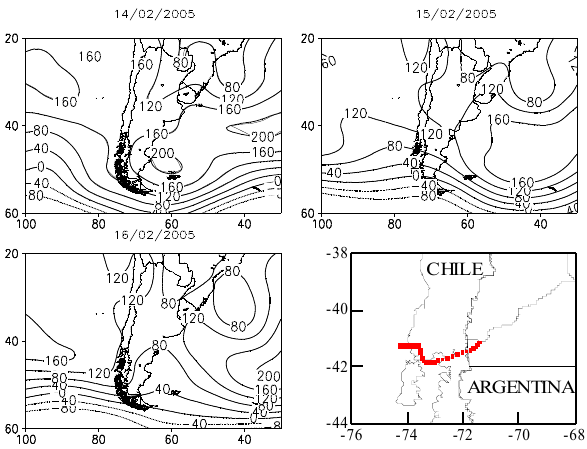
Fig. 4. Daily mean geopotential height fields of 1000hPa pressure surface for the day of Weinmannia pollen capture and 48 hours before. Bottom right panel: 48h backward trajectory started at 24:00hlocal time 16 February 2005 in San Carlos de Bariloche.